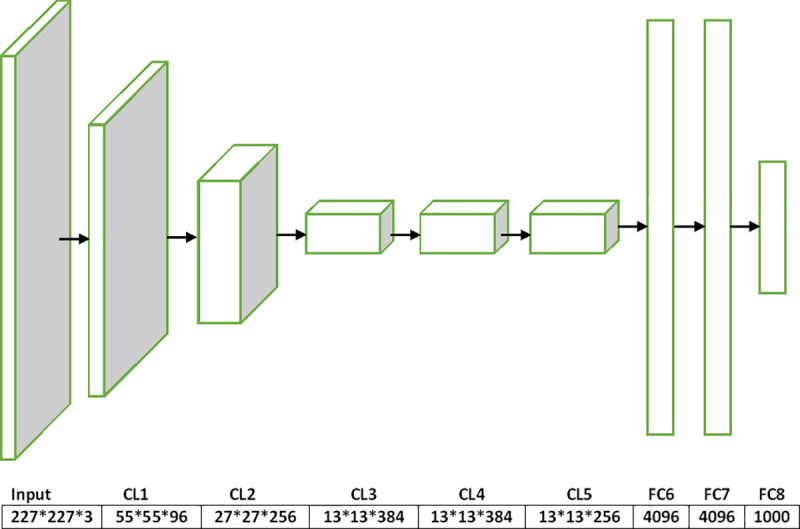
AlexNet architecture.